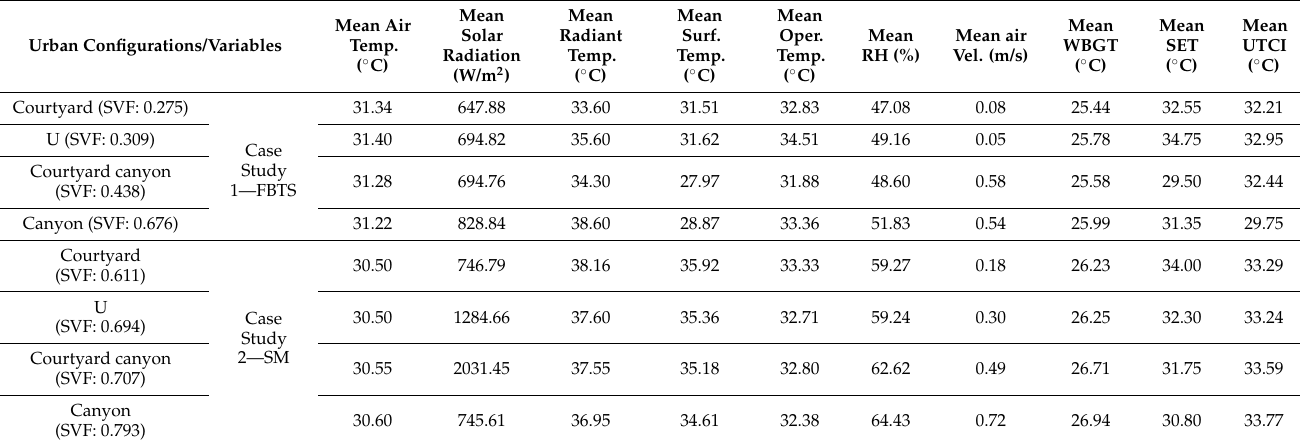
Table 6. Overall mean values of environmental variables and thermal indices for various urban configurations in the case